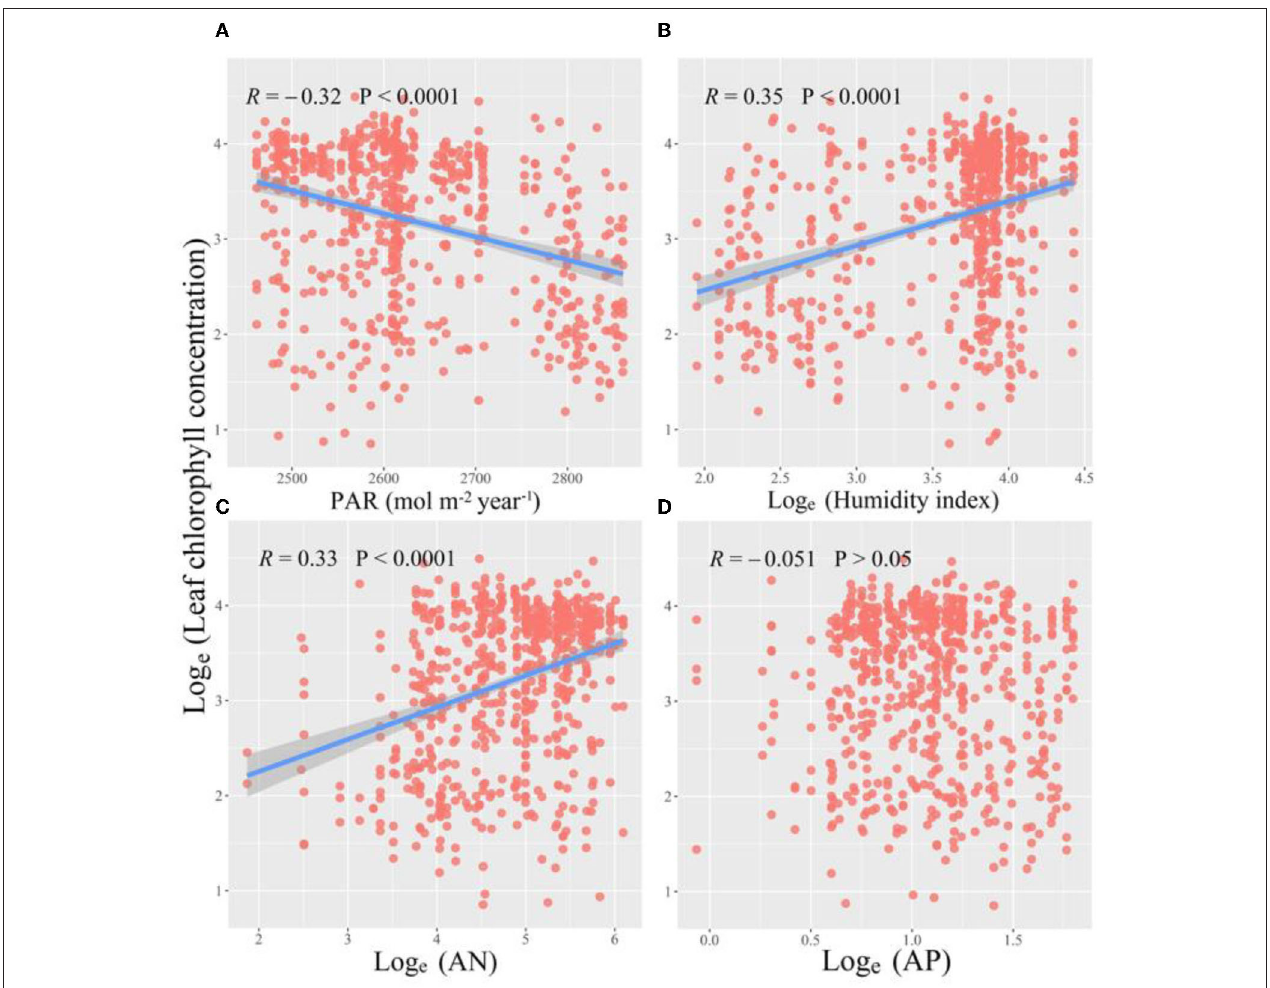
FIGURE 2 | Relationships of leaf chlorophyll (Chl) with PAR [ (A) photosynthetically active radiation], humidity index (B) , AN [ (C) soil available nitrogen], and AP [ (D) soil available phosphorus]. Red dots represent species-specific observations in each site. The blue lines and shades represent the regression lines with a 95% confidence